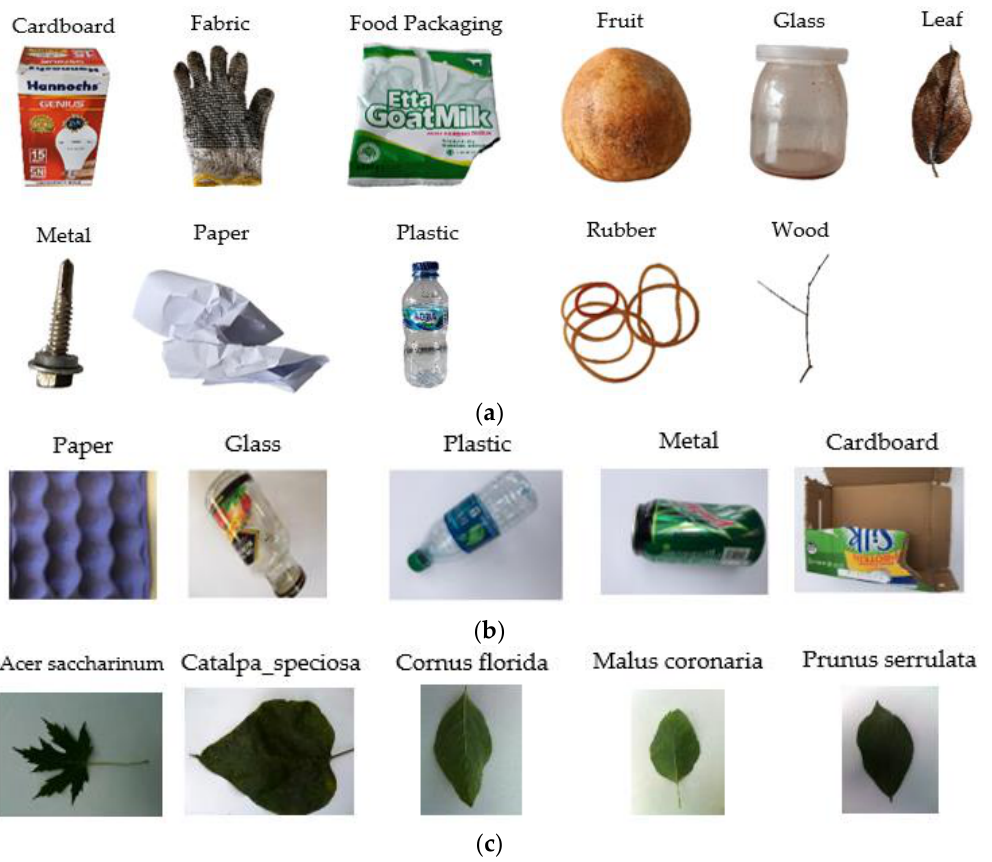
Figure 3. ( a ) Sample images of own trash dataset. ( b ) Sample images of the TrashNet dataset. ( c ) Sample images of the LeafSnap dataset.